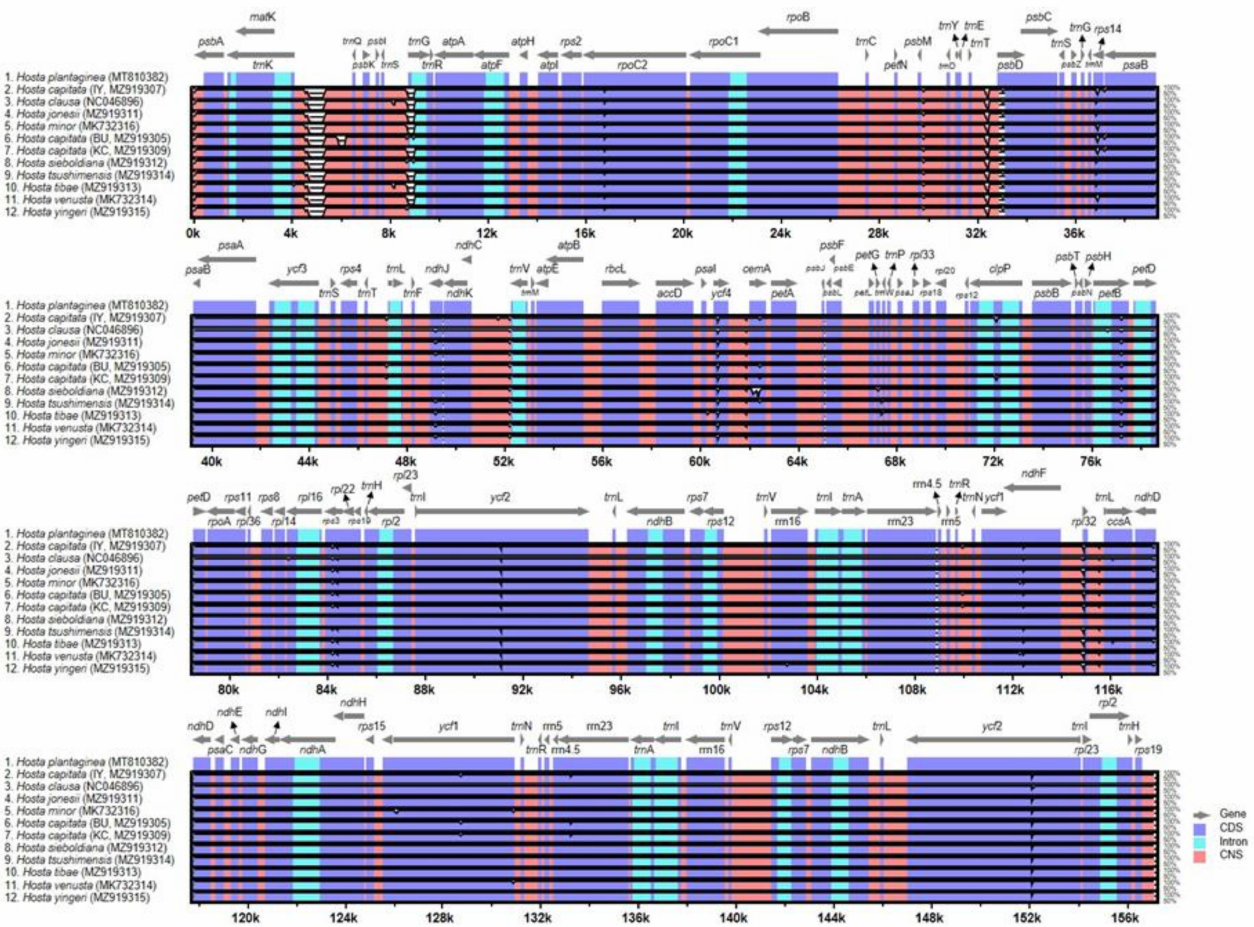
Figure 3. Visualization of the alignment of 12 Hosta species chloroplast genome sequences. The VISTA-based identity plots using mVISTA in the Shuffle-LAGAN show the sequence identity of 12 Hosta species. The vertical scale indicates the percent identity from 50 to 100%. Coding and non-coding regions are in blue and pink, respectively. Gray arrows above the alignment indicate the position and direction of each